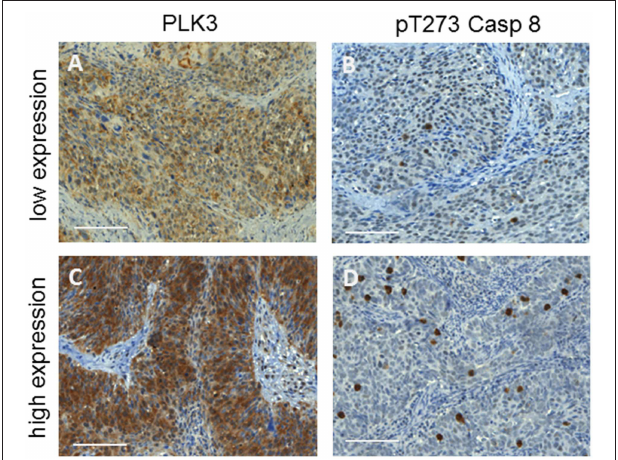
FIGURE 1 | Examples of cervix cancer biopsies with a low (A,B) or high (C,D) immuno-histochemical detection of PLK3 and pT273 caspase 8. Original magnification × 40, scale bars: 100 µ